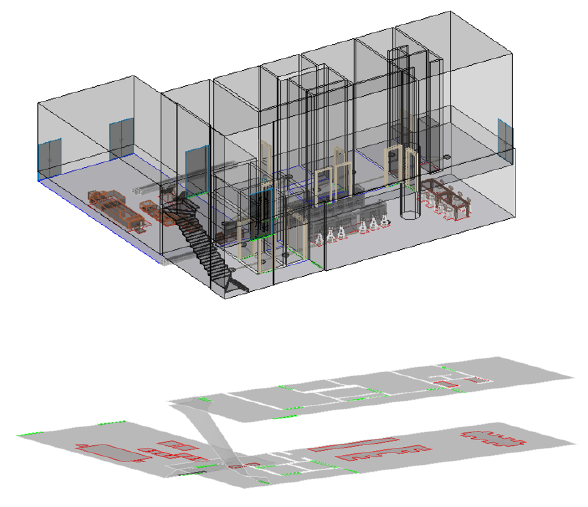
Figure 1. Illustration of indoor vector map generation